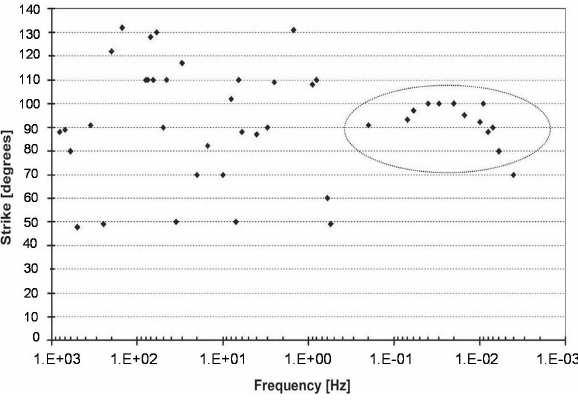
Fig. 4 Fig. 4. Strike versus frequency; in ellipse is the frequency range where 2-D structures have a strike direction of about 95 ◦ –98 ◦ .